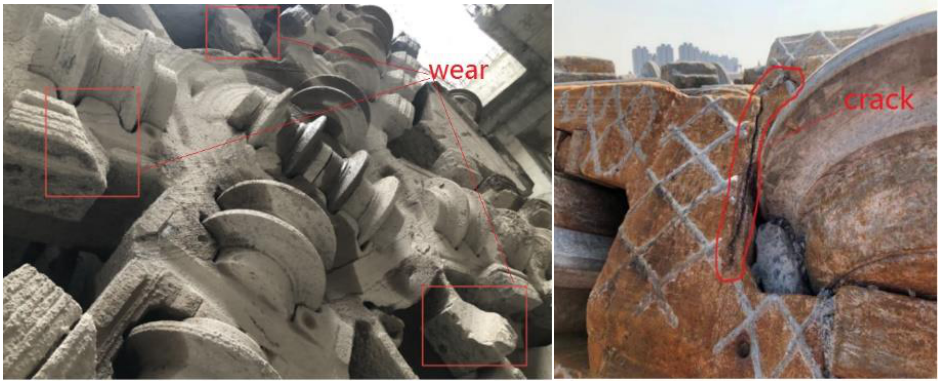
Figure 2. Failed cutterhead of a shield machine.